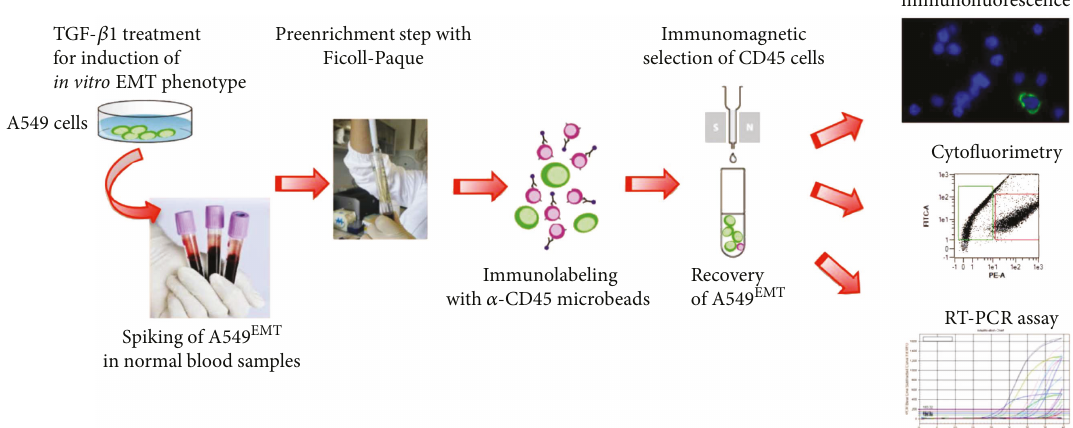
Figure 1: Schematic drawing of the immunomagnetic isolation and detection of A549 EMT cells. After negative enrichment by immunomagnetic depletion of leukocytes, putative A459 EMT cells spiked in the normal blood samples were analyzed with quantitative immuno fl uorescence microscopy, cyto fl uorimetry, and RT-PCR